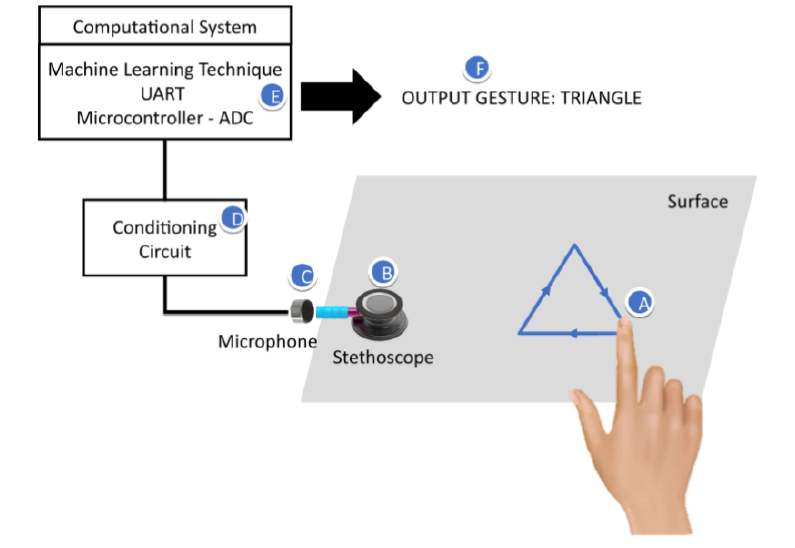
Figure 1. Functioning of the proposed